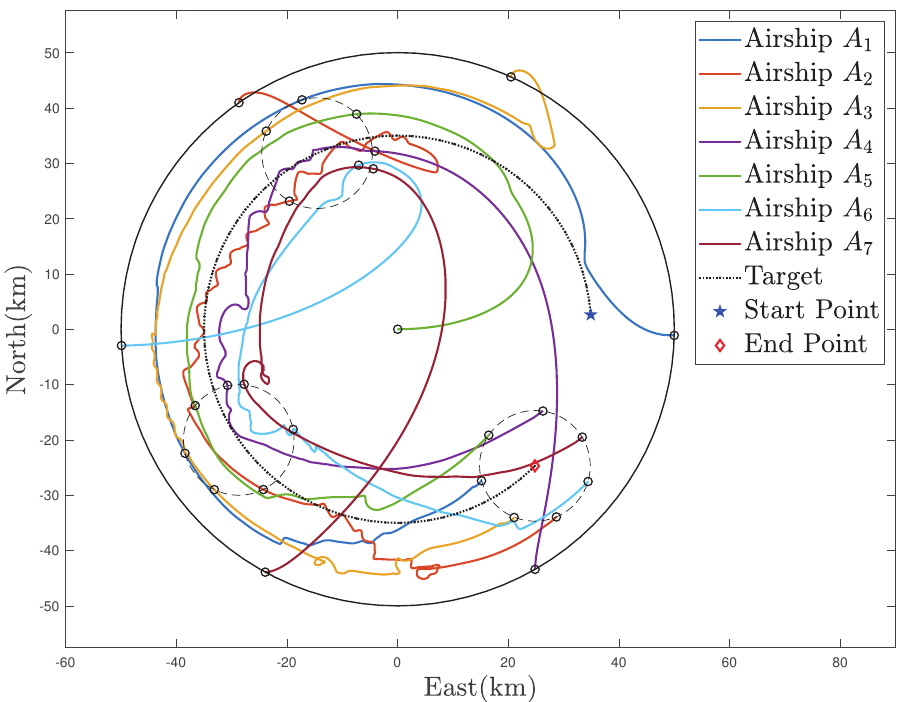
Figure 15. Trajectories of the MSAs system in the moving target coverage process with traditional APF-based